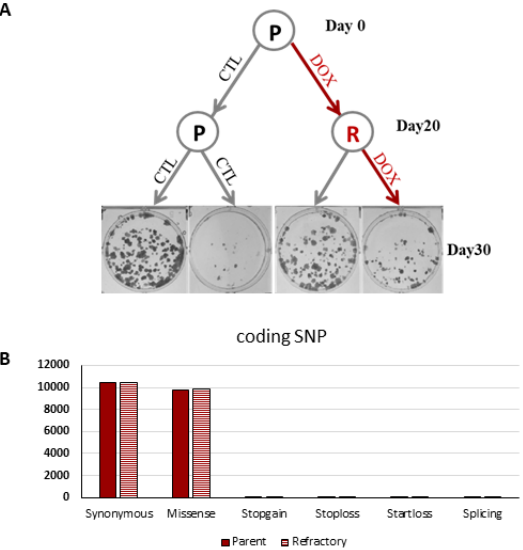
Figure 3. Inducible HPV16E6E7 knockdown refractory cells have lower copies of HPV16E6E7 shRNA. UMSCC47-shRNA4 cells were unstimulated or stimulated with doxycycline for 20 contin- uous days to generate a paired parental and refractory cell line. ( A ) Colony formation assay. Paren- tal and refractory cells were plated and treated with control or doxycycline for 10 days. Representa- tive cell culture plates are shown for each experimental condition. ( B ) Whole exome sequencing. Exonic SNVs were unchanged between UMSCC47-shRNA parental and refractory cells.